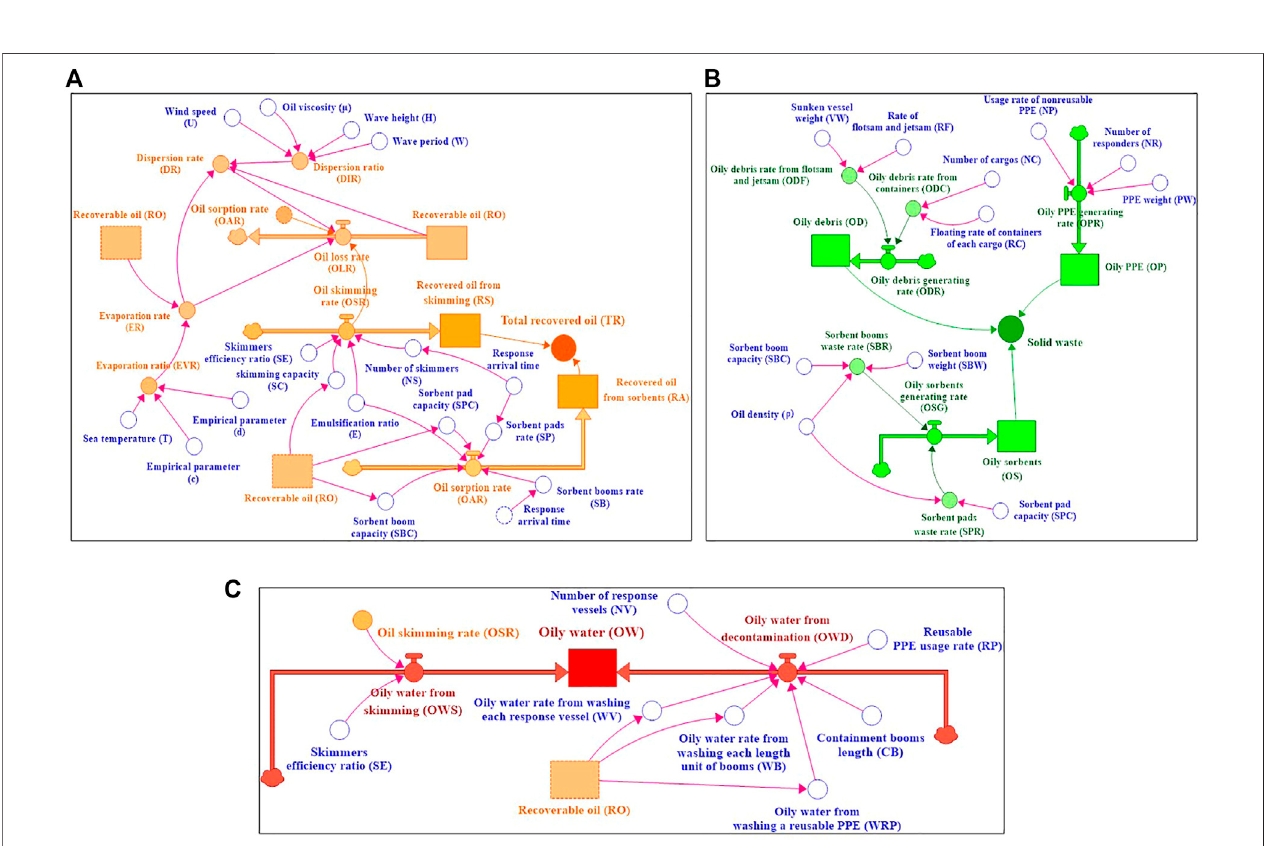
FIGURE 1 | Overview of the system dynamics model for estimating (A) recovered oil, (B) oily water, (C) solid waste collected from oil spill response.